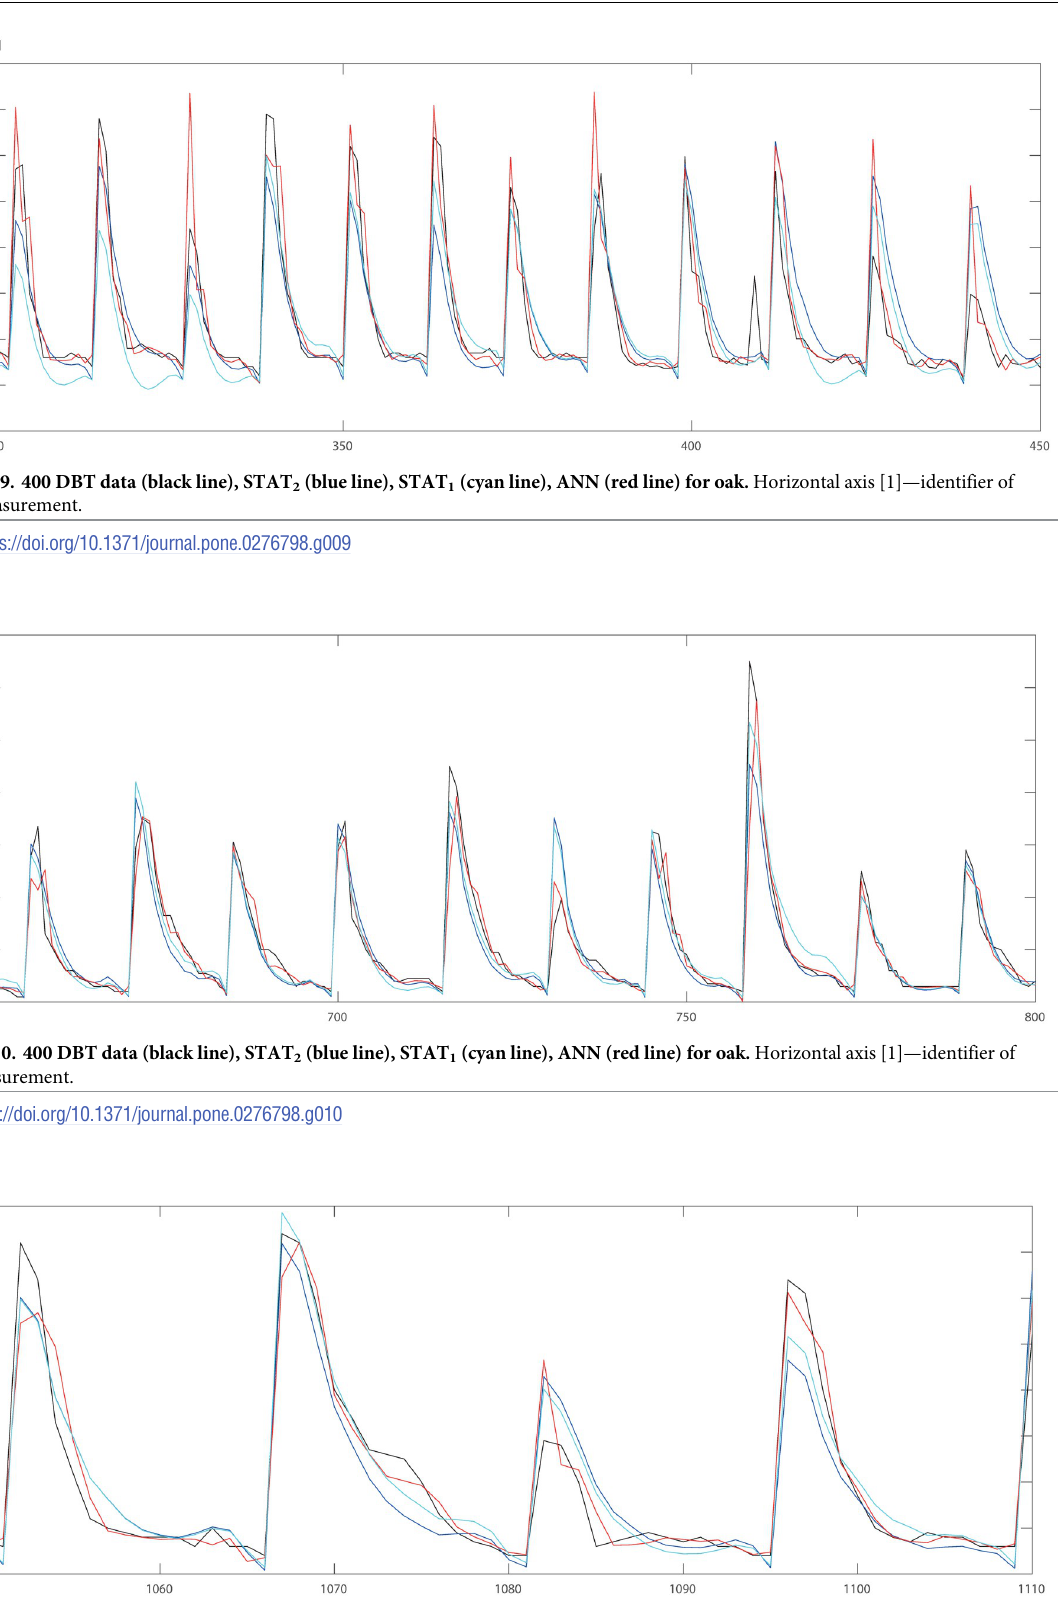
Fig 11. 400 DBT data (black line), STAT 2 (blue line), STAT 1 (cyan line), ANN (red line) for oak. Horizontal axis [1]—identifier of measurement. https://doi.org/10.1371/journal.pone.0276798.g011 PLOS ONE | https://doi.org/10.1371/journal.pone.0276798 November16,